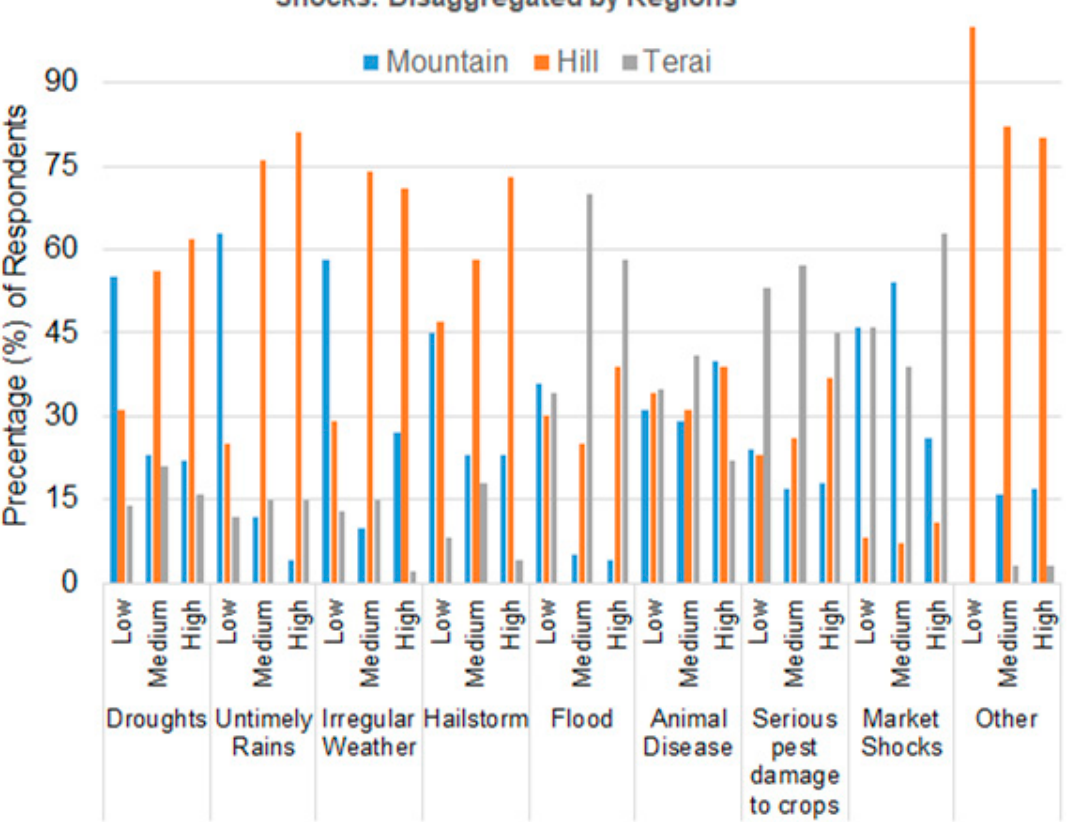
Figure 7. Severity of the risks to shocks perceived by households in the Karnali-Mahakali Basins—disaggregated by the type of shocks as well as physiographic regions.